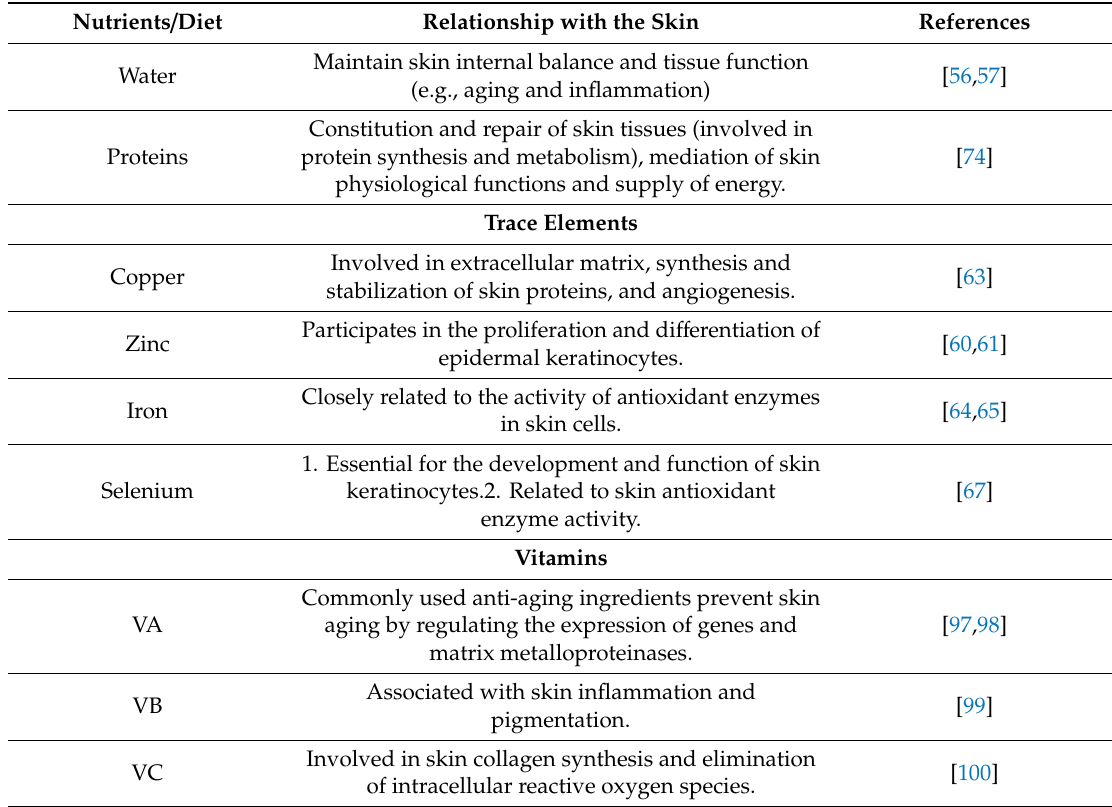
Table 1. Summary of key e ff ects of nutrients and diet in skin